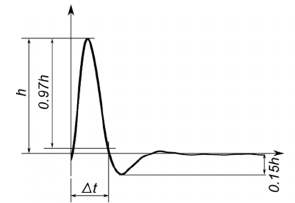
Figure 1. Optimal dynamic response of the hot-wire anemometer.